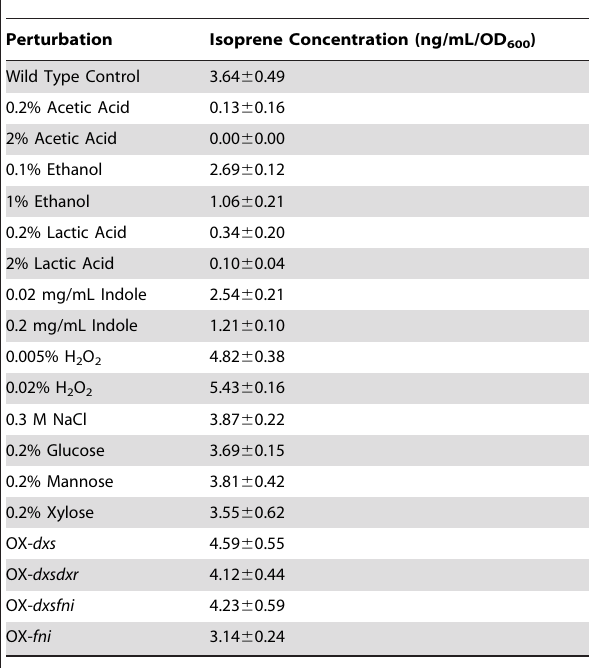
Table 1. Concentration of isoprene produced in B. subtilis under different environmental and genetic